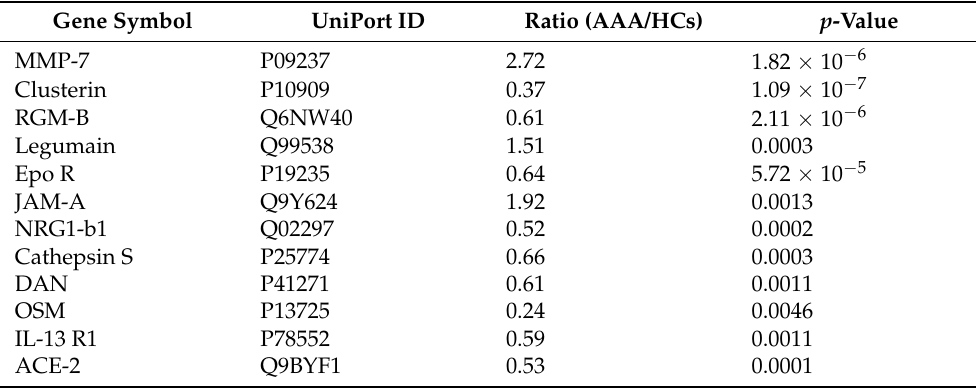
Figure 1. Bioinformatics analysis of differentially expressed proteins between AAA patients and healthy controls. ( A ) Volcano plot of differentially expressed proteins; ( B ) orthogonal partial least squares discriminant analysis (OPLS − DA) result; ( C ) disease and biofunction results from IPA analysis; ( D ) canonical pathway results from IPA analysis. Table 2. Differentially expressed proteins between AAA patients and healthy controls using protein array analysis.